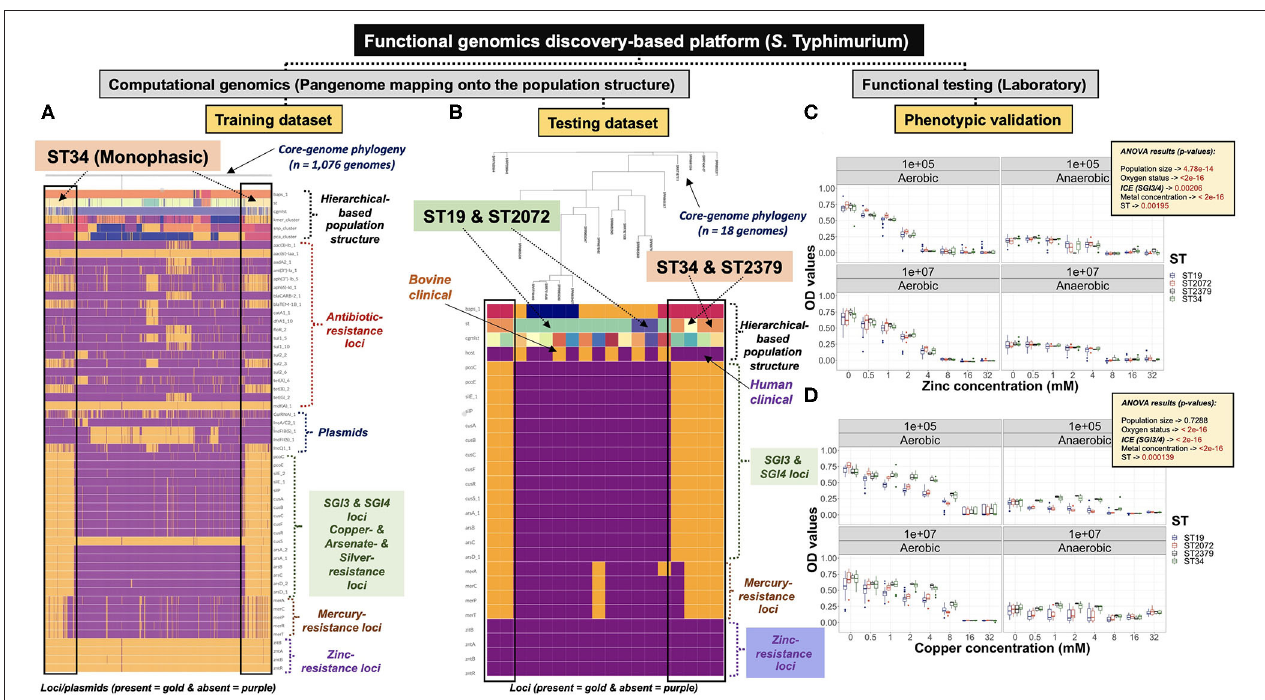
FIGURE 5 | Functional genomics discovery platform combining population genomics and phenotypic validation showed a preferential occurrence of SGI-3/4 in the S . Typhimurium ST34-Monophasic lineage. (A) Core-genome phylogeny-based analysis combining the S . Typhimurium hierarchical population structure, along with loci (e.g., AMR genes) and plasmids, differentiating ST34 from other STs. A training dataset containing 1,076 genomes, representing group 1 of the 20 independent training datasets, was used for discovery of genomic attributes preferentially inherited by ST34. (B) A testing dataset containing representative STs (Biphasic vs. Monophasic) and distinct cgMLSTs, comprised of human ( n = 12) and bovine ( n = 6) clinical isolates was used for validation of predicted phenotypes. Specifically, ST34 ( n = 5) and ST2379 ( n = 1) were predicted to be more resistant to heavy metals such as copper than ST19 ( n = 10) and ST2072 ( n = 2); whereas, all isolates were expected to be comparably susceptible to high doses of zinc. Phenotypic testing for either zinc (C) or copper (D) resistance, using a biological gradient approach, was carried out under aerobic and anaerobic conditions, while considering two different initial population sizes (i.e., 10 5 or 10 7 CFU/ml). (C) The pattern of zinc susceptibility was comparable across all isolates, with a significant impact of the oxygen status; for which maximum growth, regardless of the ST-background, was only achieved under aerobic condition, but was negatively impacted by the increasing zinc concentration. (D) On average, STs containing the SGI-3/4 genetic element (ST34 and ST2379) resisted higher concentrations of copper ( ∼ up to 2-8mM), regardless of the population size and oxygen status. For plots (A) and (B) , each column represents a single genome, and each row represents either a locus or plasmid. For either loci or plasmids, presence is depicted by the color gold, and absence by purple. For plots (C) and (D) , p -values for each main effect were generated using multivariate ANOVA models. OD values were measured at 600nM. Core-genome phylogeny guided mapping of population structure and genetic elements were visualized with phandango ( A,B